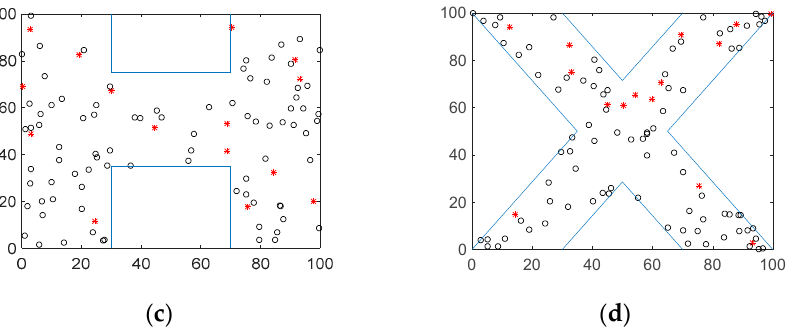
Figure 2. Anisotropic networks in simulation. ( a ) C-shape network. ( b ) S-shape network. ( c ) H-shape network. ( d ) X-shape network. Table 2. The simulation parameters.